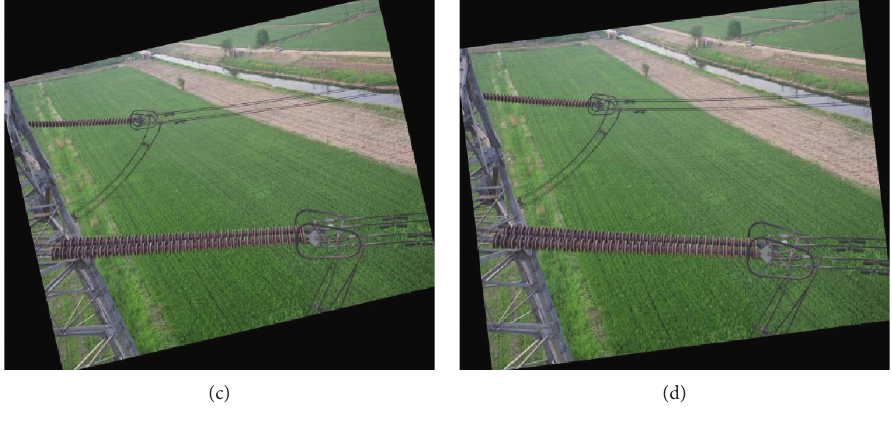
Figure 7: Images before and after rotation. Table 1: Test results before and after histogram equalization.